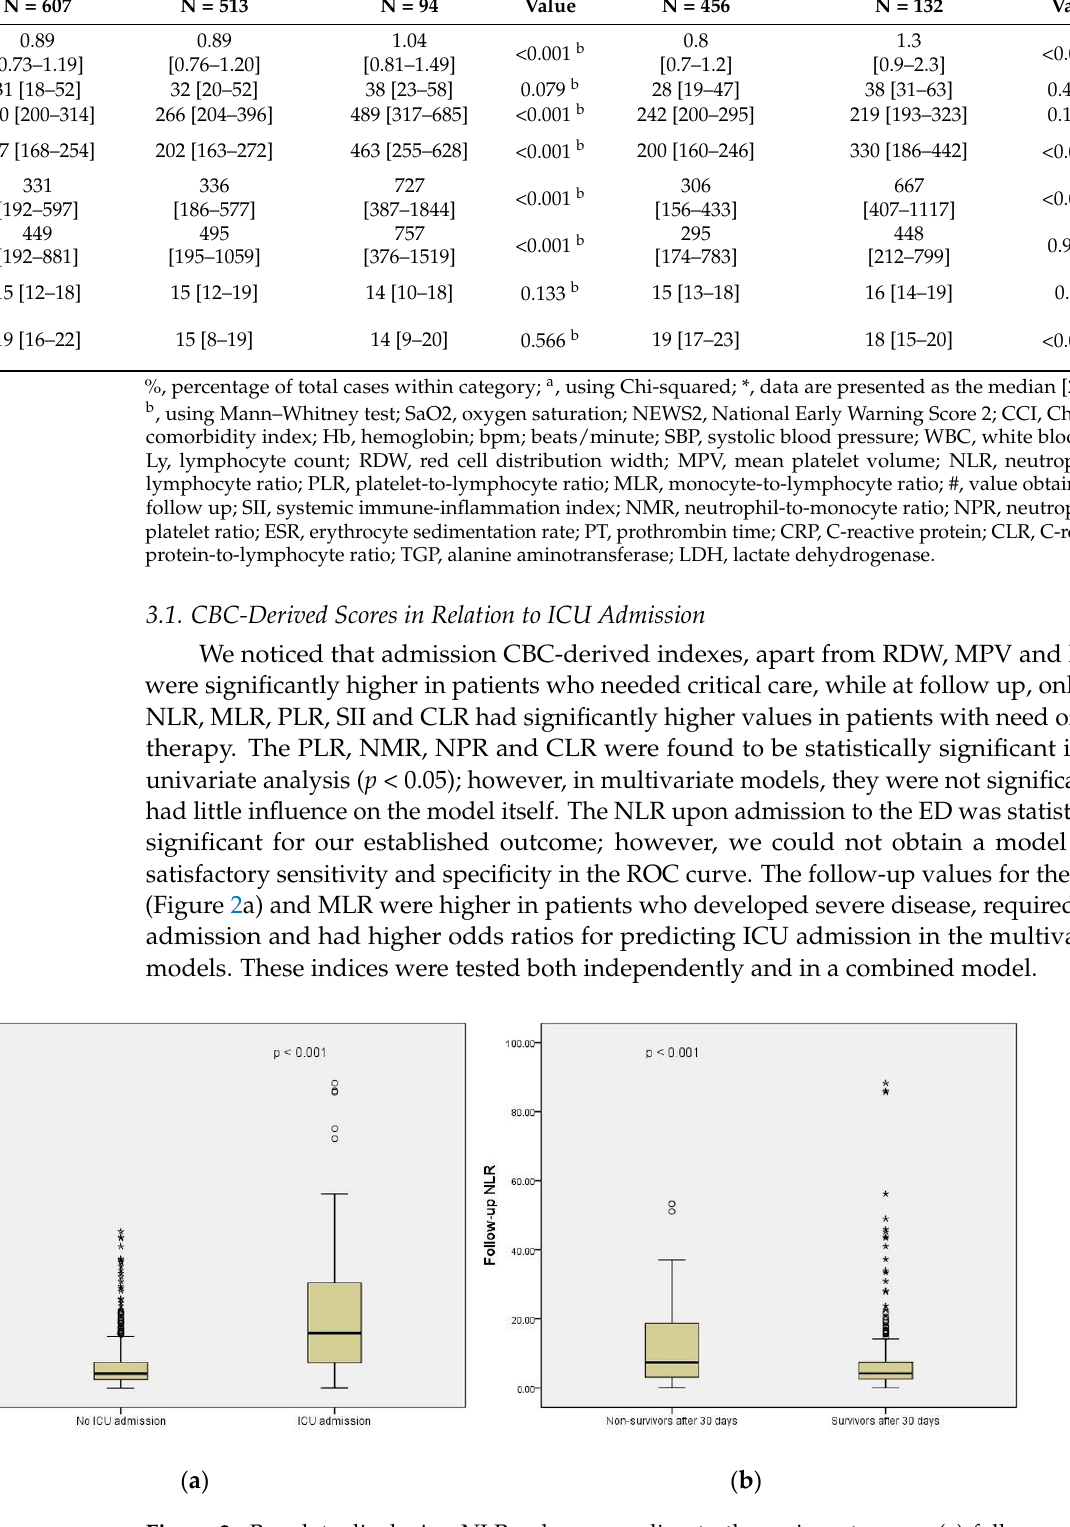
( b ) Figure 3. ROC curve for the predictive models including NLR and MLR in relation to the main outcomes: ( a ) the predictive models for ICU admission; ( b ) the predictive models for short-term mortality. Table 2. Logistic regression models for the main outcomes’ prediction including follow-up NLR. Variable